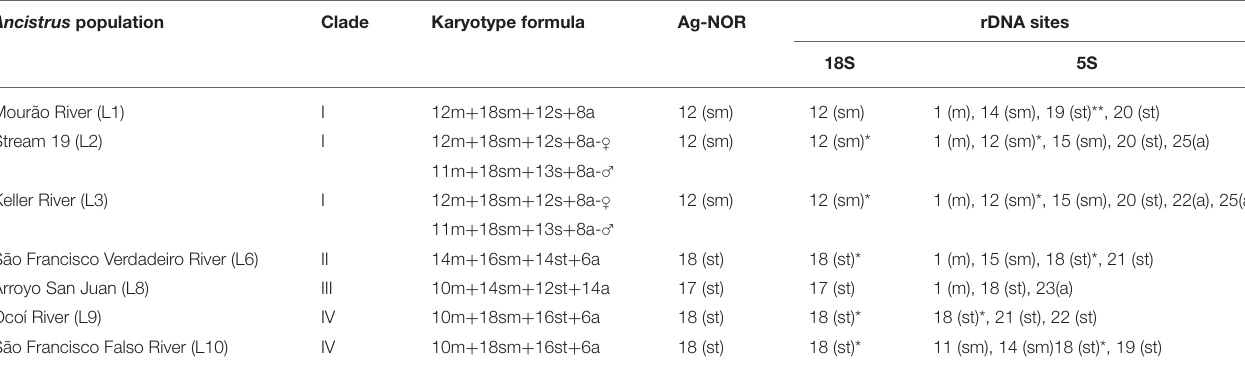
TABLE 3 | Cytogenetic parameters of the Ancistrus populations sampled in the different rivers of the Paraná basin. Ancistrus population Clade Karyotype formula